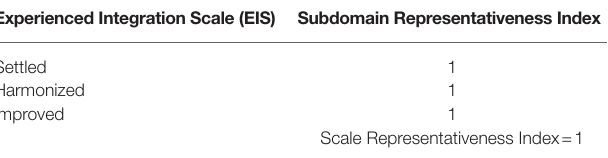
TABLE 5 | Experienced integration scale representativeness